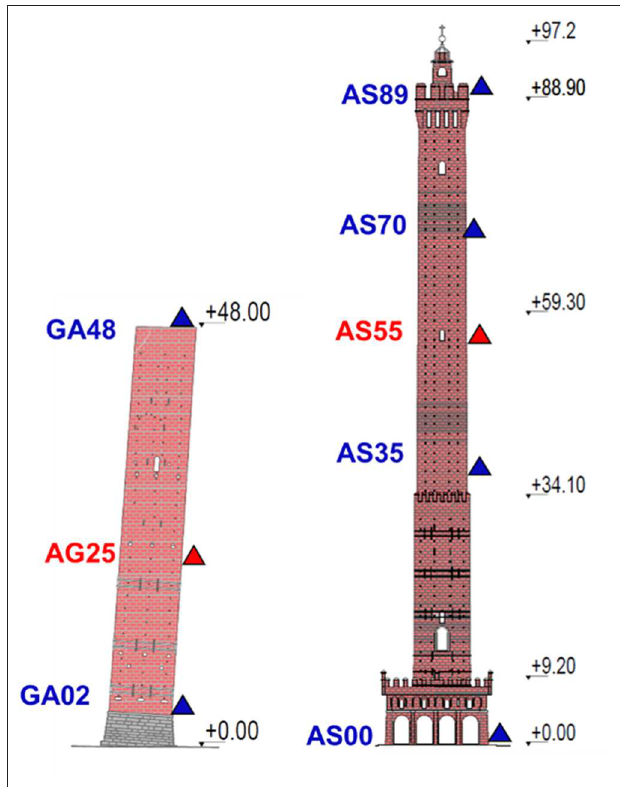
FIGURE 2 | Position of the seismometers on the Asinelli (Right) and Garisenda (Left) Towers.